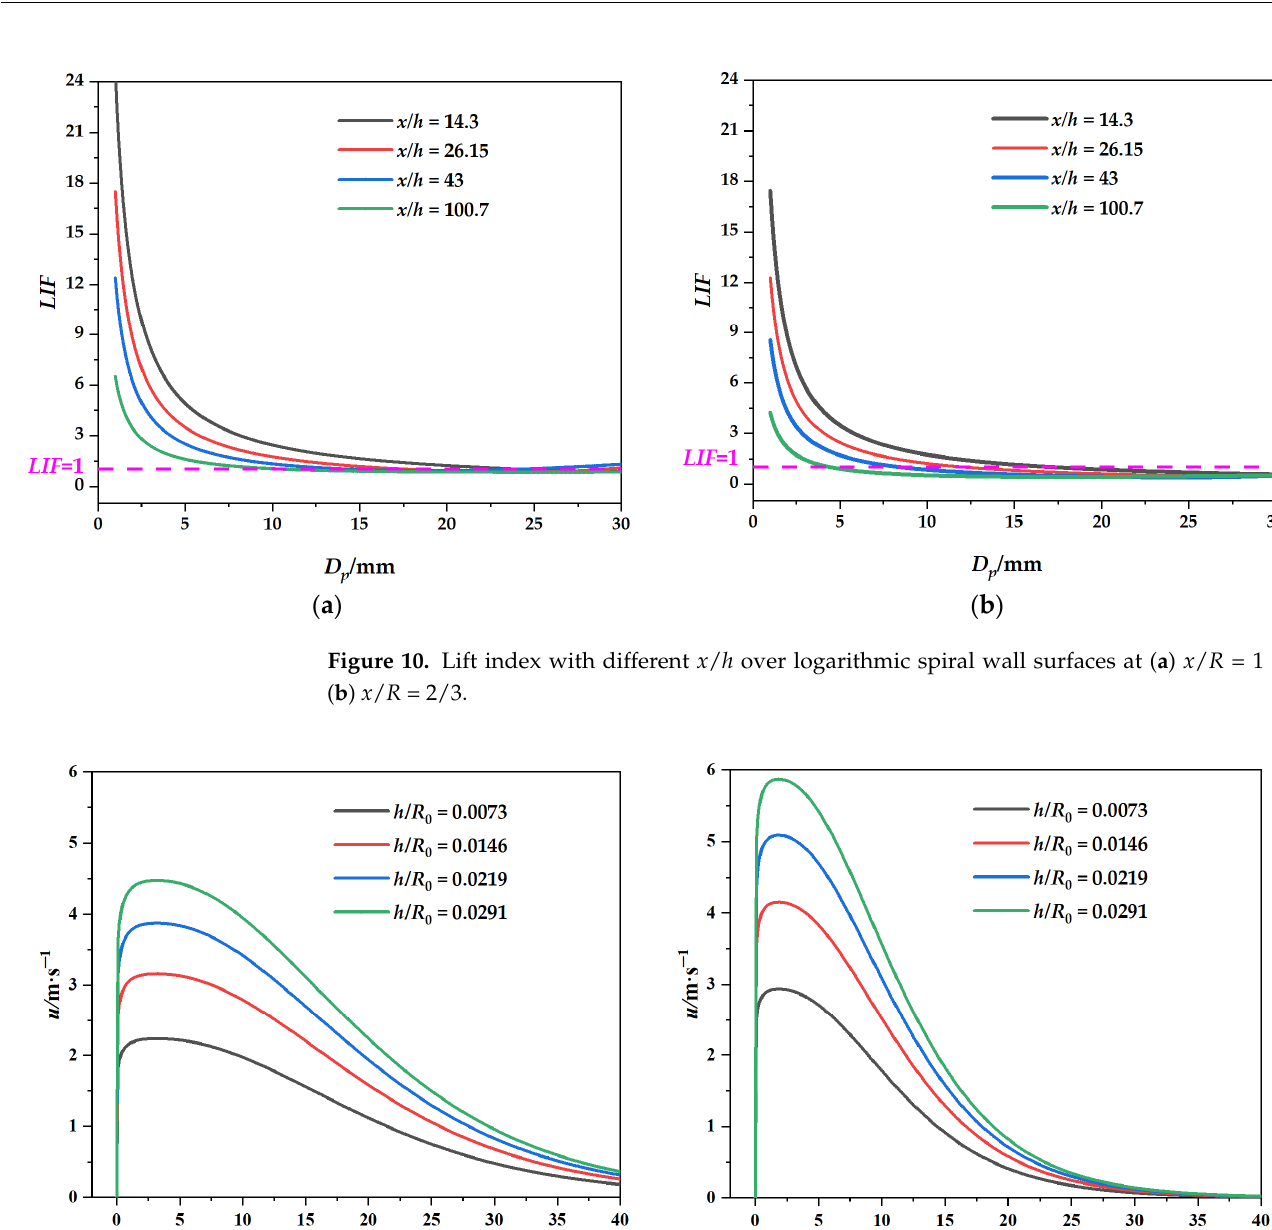
Figure 9. Pressure distribution with different x/h over logarithmic spiral wall surfaces at ( a ) x / R = 1 and ( b ) x / R = 2/3.